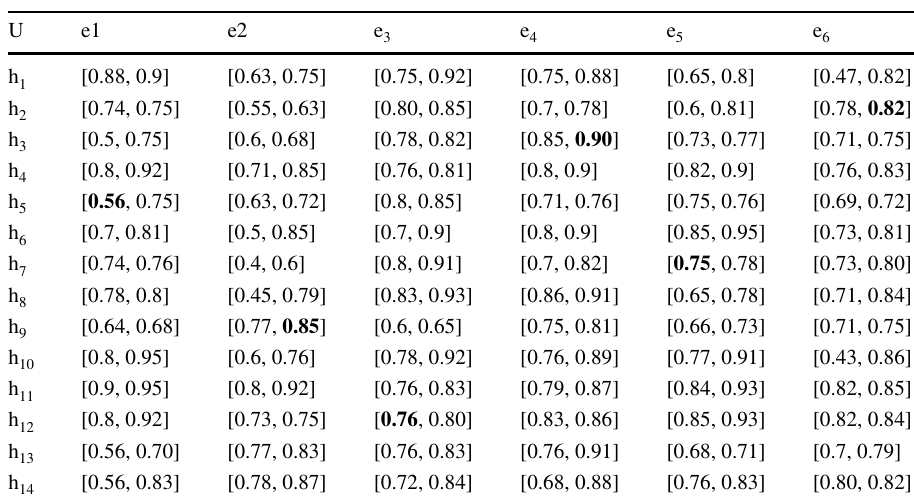
Bold indicates the data after